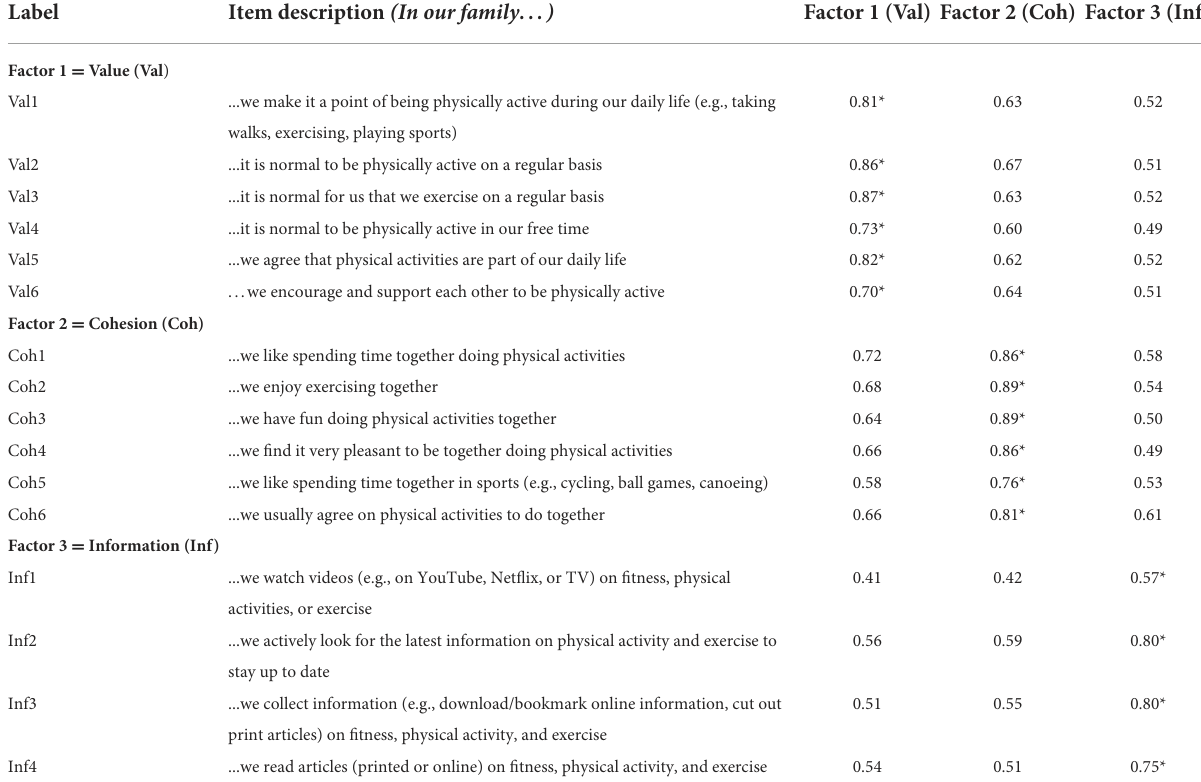
TABLE 4 Item-total correlations of FHC-PA (Sg) scale. FHC-PA (Sg) Item-total